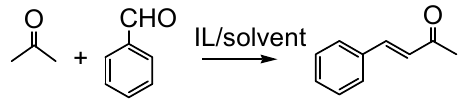
Table 1. Aldol reactions of benzaldehyde and acetone (model reaction) in